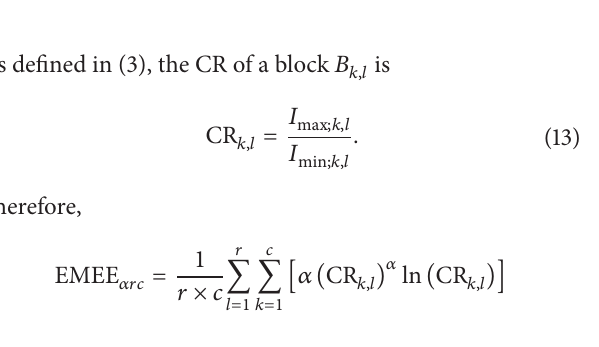
Figure 1: Images with different